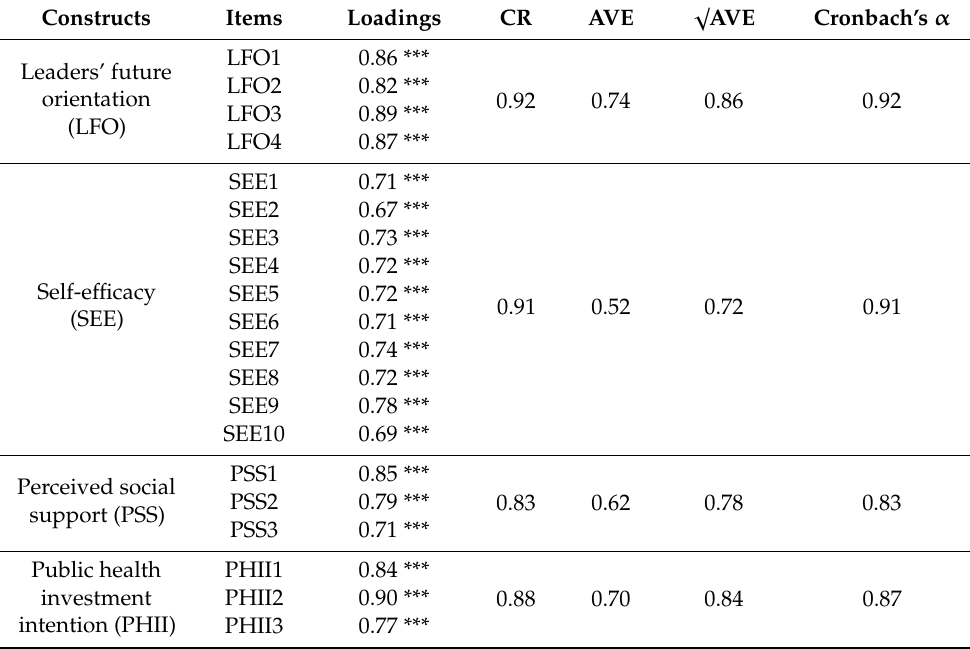
Table 4. Confirmatory factor analysis